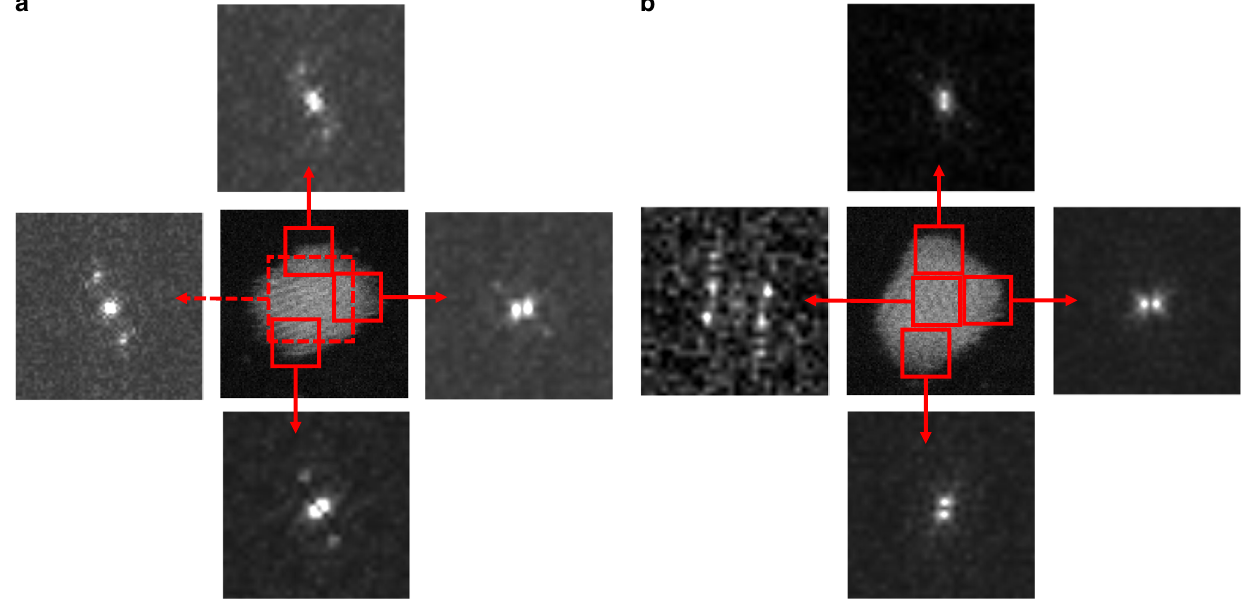
Fig. 3 Power spectrum FFT images of various regions of a Au 561 nanocluster. The nanocluster at a 600 °C and b 657 °C